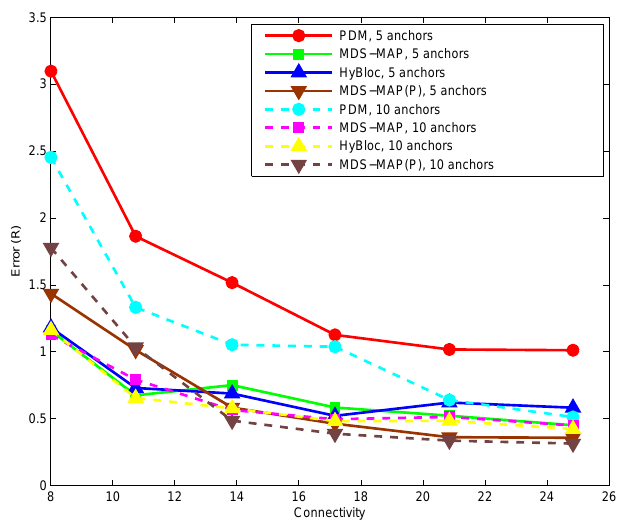
Figure 10 . Clustered anchors, α = 0.1, Uniform